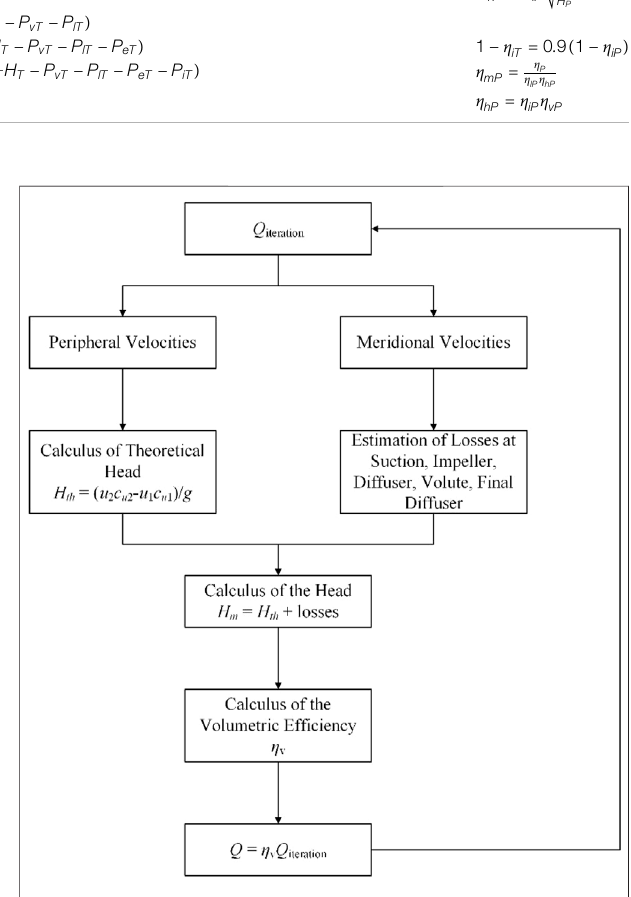
FIGURE 3 | Flowchart of performance calculation in Barbarelli ’ s method (Barbarelli et al.,